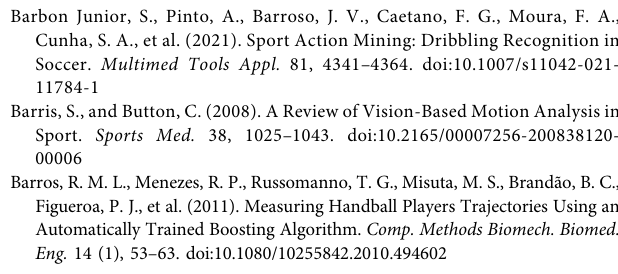
Figueroa, P. J., et al. (2011). Measuring Handball Players Trajectories Using an Automatically Trained Boosting Algorithm. Comp. Methods Biomech.